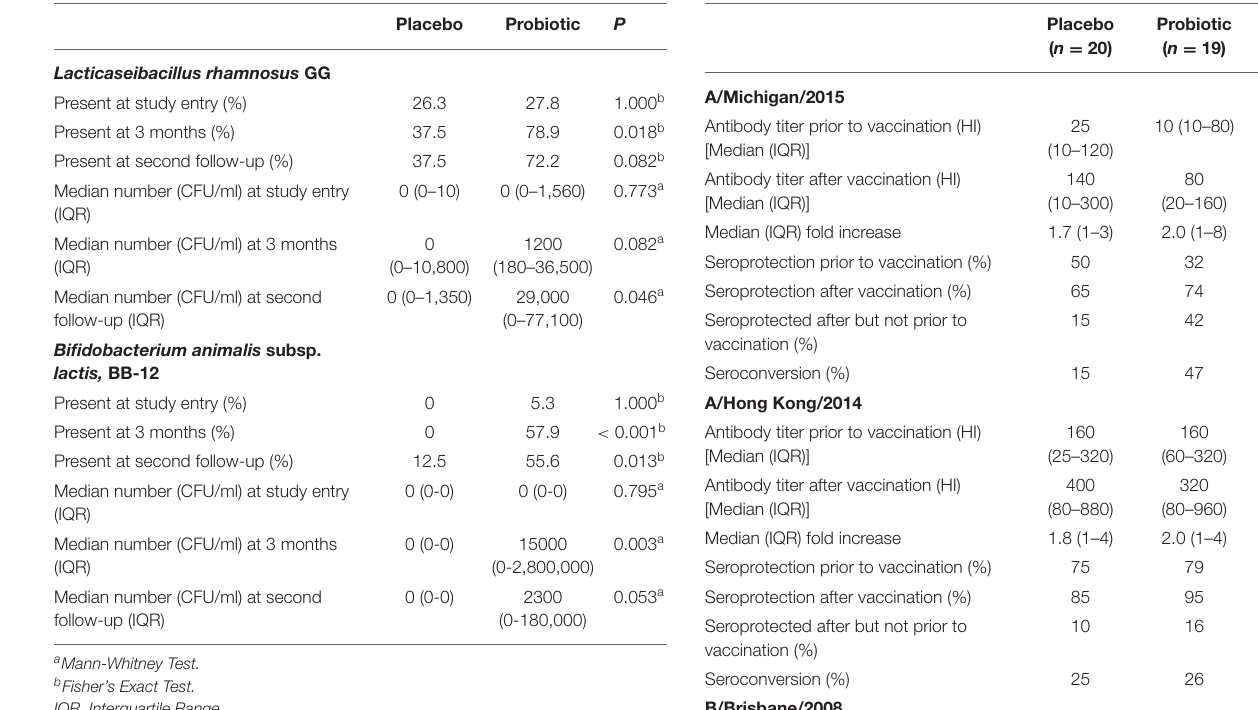
TABLE 2 | Fecal Lacticaseibacillus rhamnosus GG and Bifidobacterium animalis subsp. lactis, BB-12 in participants in the placebo and probiotic groups.